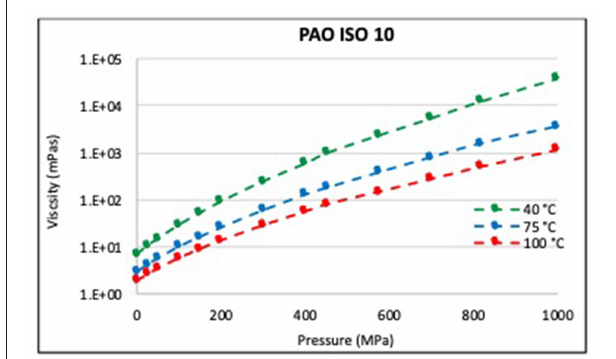
FIGURE 2 | Viscosity (mPa-s) as a function of pressure and temperature for PAO ISO 10.